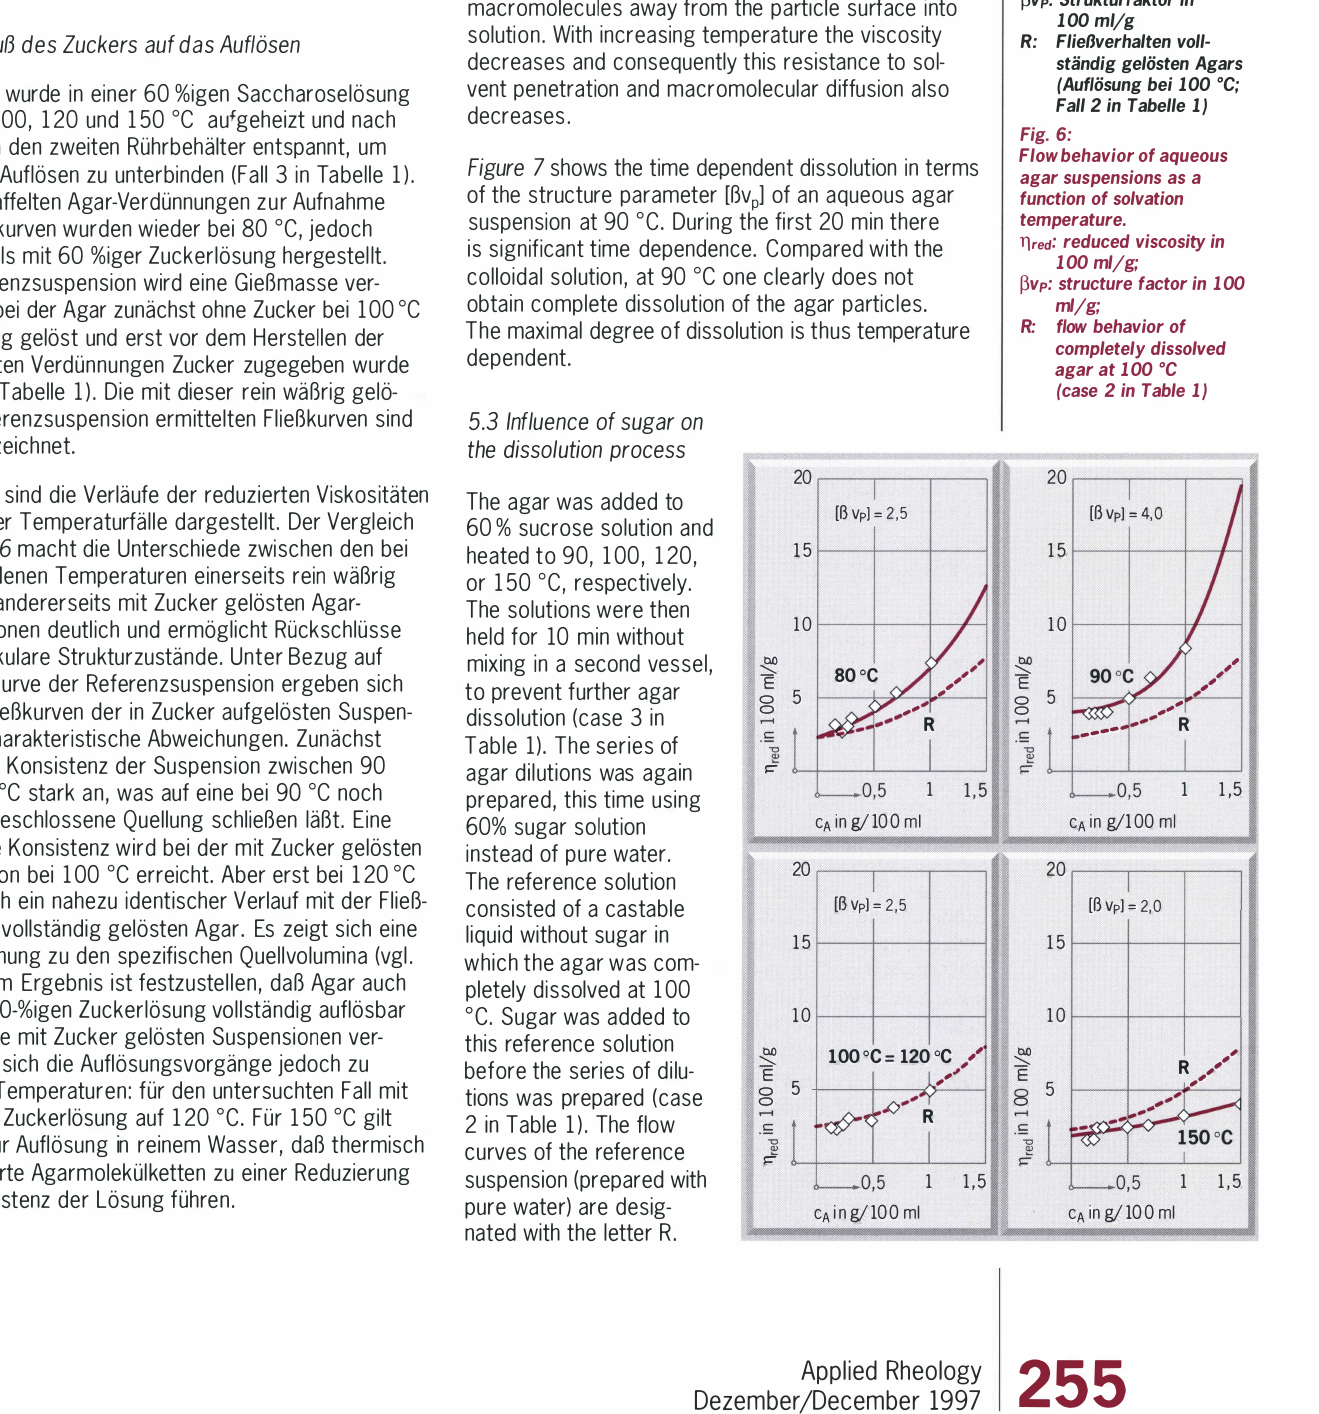
R: FlieBverhalten voll­ standig gelosten Agars